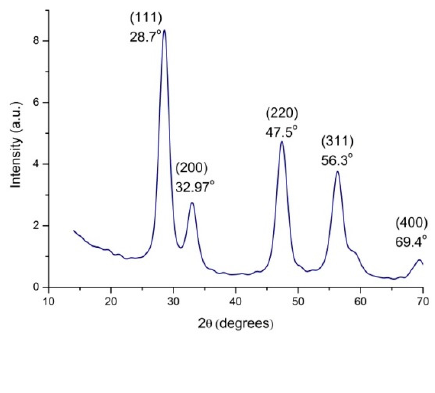
pristine CeO 2 powder.